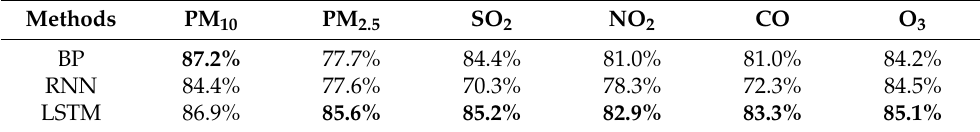
Table 10. The accuracies of LSTM network compared with traditional networks in dataset 3.